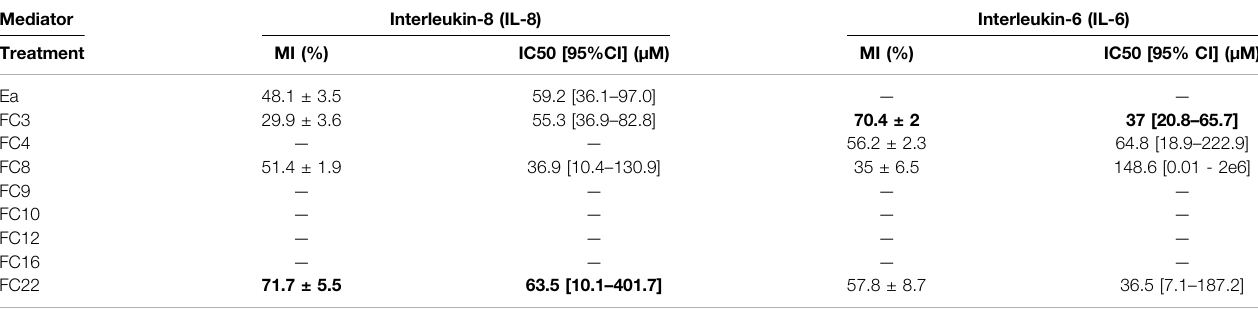
TABLE1| Summaryofinhibitoryeffectsof Entadaafricana leafextract(Ea)anditsfractionsFC3,FC4,FC8,FC9,FC10,FC12,FC16,FC22(1 – 100 µg/mL)oncytokine(IL-8, IL-6) release from TNF α -stimulated HaCaT cells.